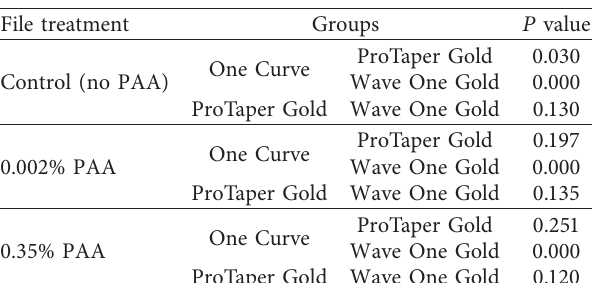
Table 5: P values of multiple comparisons by Kruskal–Wallis tests for the fragmented lengths of the tested file